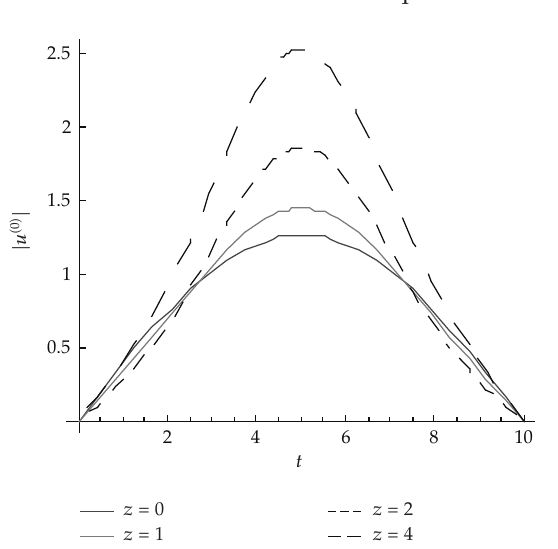
Figure 37: The first-order approximation | u (cid:3) 1 (cid:4) | at α (cid:8) 1, T (cid:8) 10, γ (cid:8) 0, ε (cid:8) 05 for di ff erent values of z , considering only one term in the series (cid:3) M (cid:8) 1 (cid:4) .